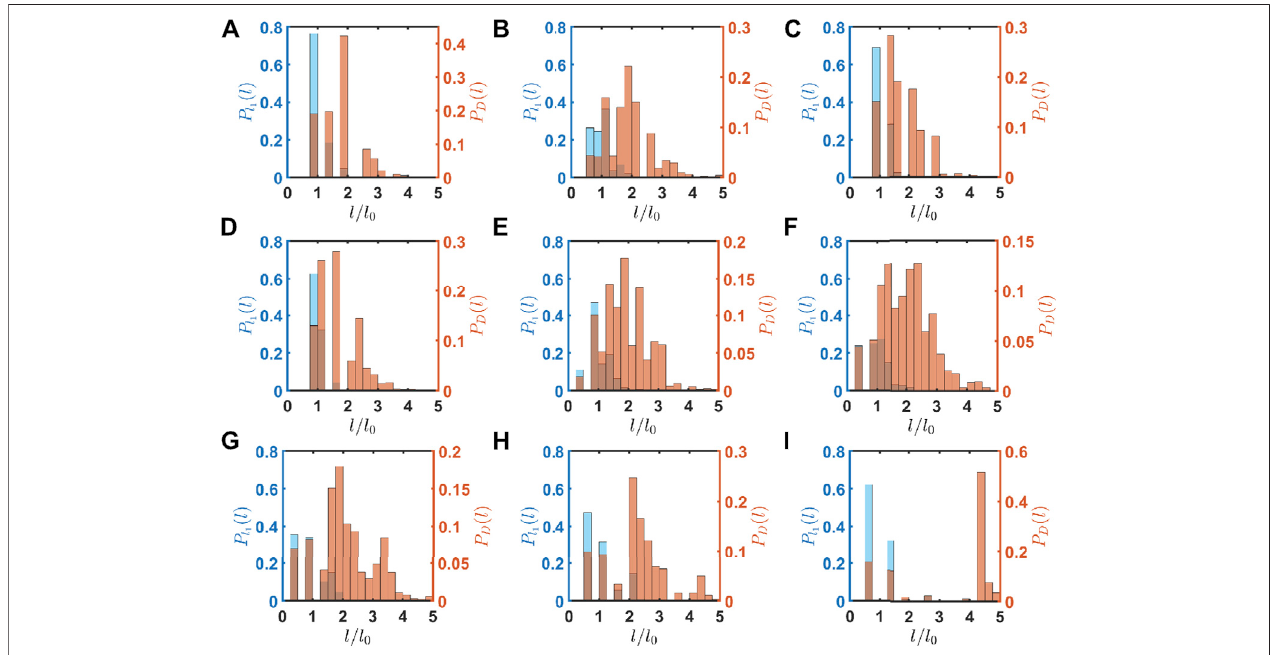
FIGURE 4 | Panels (A – I) show the probability density function P d probability density function P